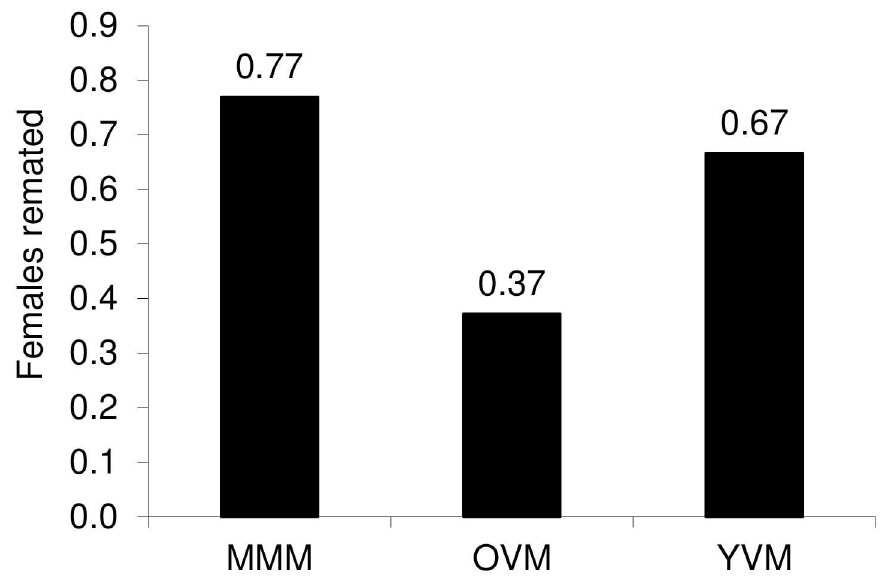
Fig 1. Probability of Ostrinia nubilalis females remating after first mating with a young virgin male (YVM), an old virgin male (OVM), or a multiple mated male (MMM).